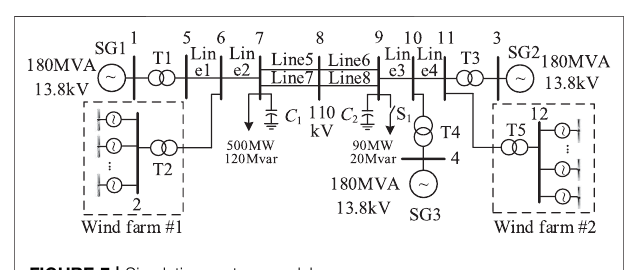
FIGURE 7 | Simulation system model.